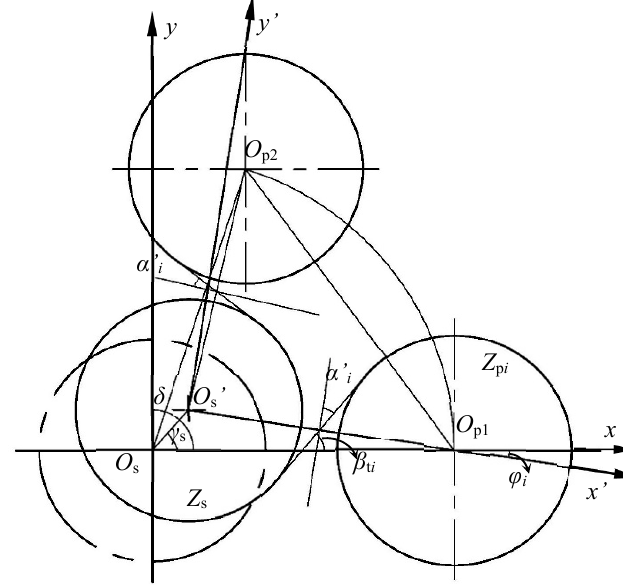
Figure 6. Equivalent engagement error of the sun gear.